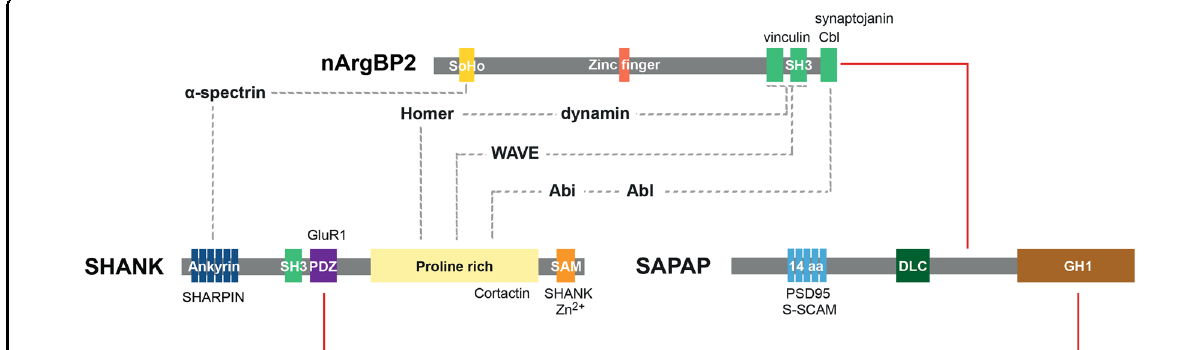
Fig. 1 The domain architectures of nArgBP2, SHANK, and SAPAP. Proteins listed with each of the domains indicate the known binding partners. Only a subset of known interacting proteins is shown. nArgBP2, SHANK, and SAPAP interact with each other either directly via speci fi c domains (red lines) or indirectly through common binding partners (broken lines). SAPAP interacts with nArgBP2 via its proline-rich region between the DLC and GH1 regions. 14 aa 14 amino acid domain, Abi Abelson interacting protein-1, DLC dynein light chain, GH1 GKAP homology 1, nArgBP2 neural Arg binding protein 2, PDZ PSD95 Dlg1 and zo-, 1 PSD95 postsynaptic density protein 95, SAM sterile alpha motif, SAPAP SAP90/PSD95-associated protein, SHANK SH3 and multiple ankyrin repeat domains, SH3 Src homology 3 domain, SoHo sorbin homology domain, S-SCAM synaptic scaffolding molecule, WAVE WASP (Wiskott – Aldrich syndrome protein)-family verprolin homologous